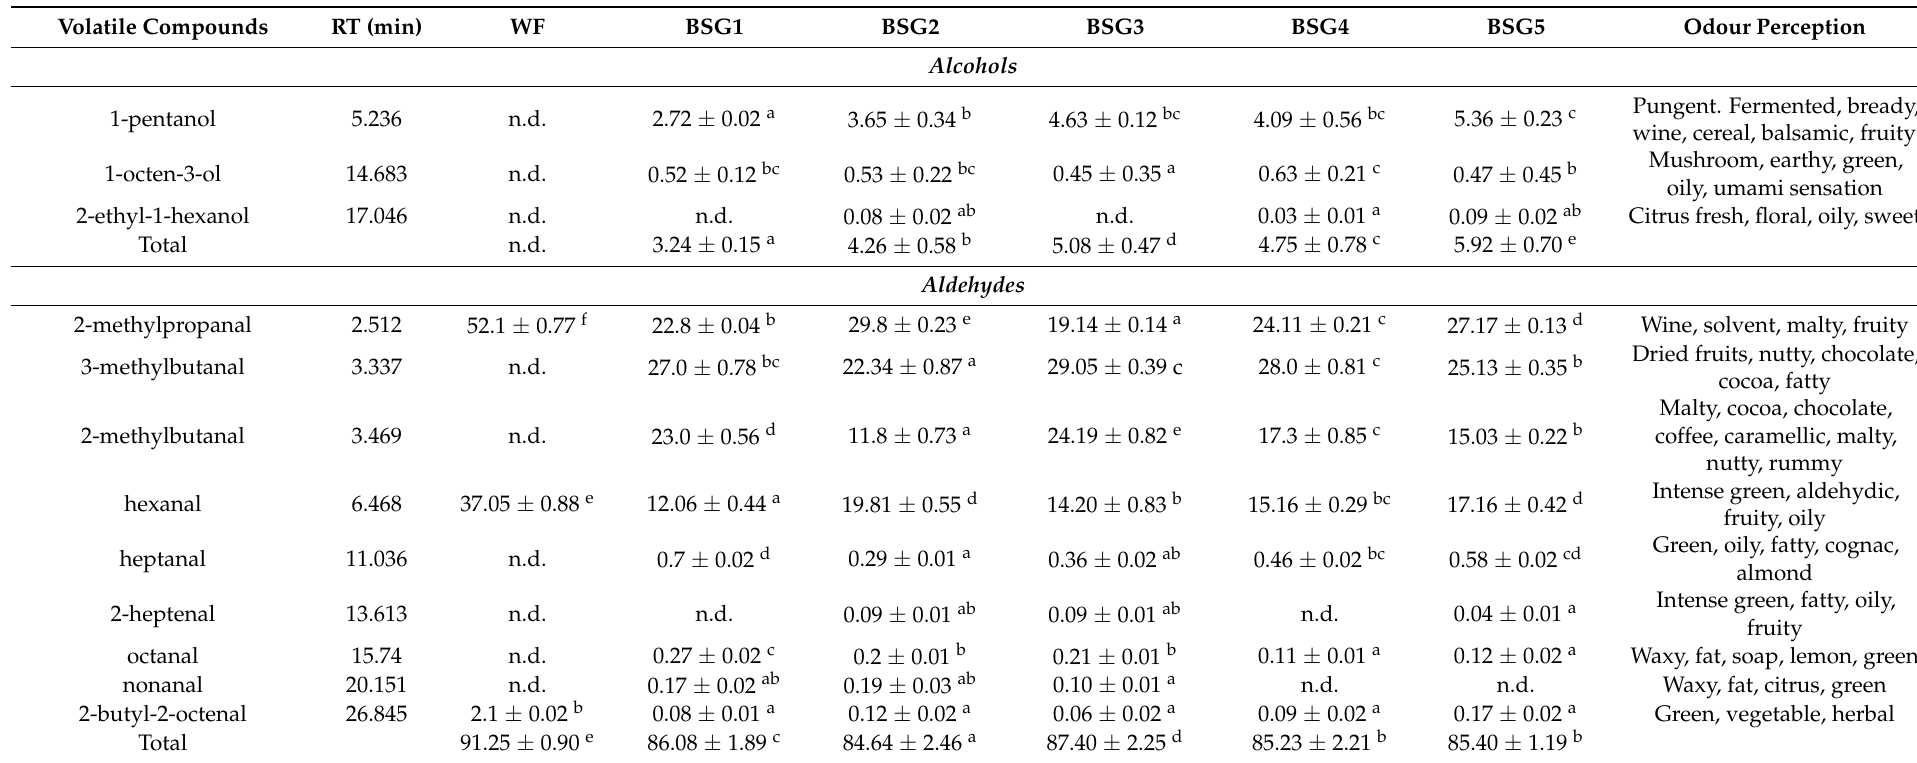
Table 4. The volatile fingerprints of WF (wheat flour) and dried BSG (brewers spent grains) samples expressed as arbitrary units (a.u.) from the relative peak areas. Volatile Compounds